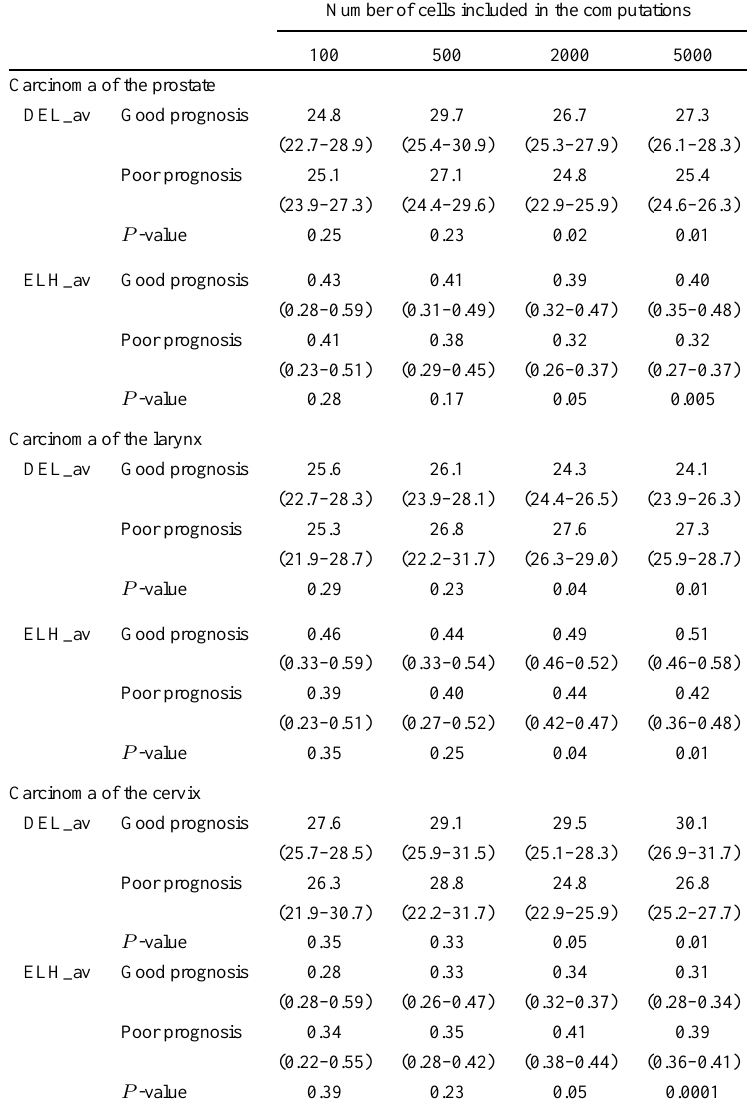
The prognostic value of the two independent structural features DEL_av and ELH_av as re- lated to the number of cells included in the computations. These two structural features attain a prognostic value ( P 6 0 : 05) approximately at the same values at which their reproducibility was acceptable (CV 6 5%). The ranges of the computations are given in